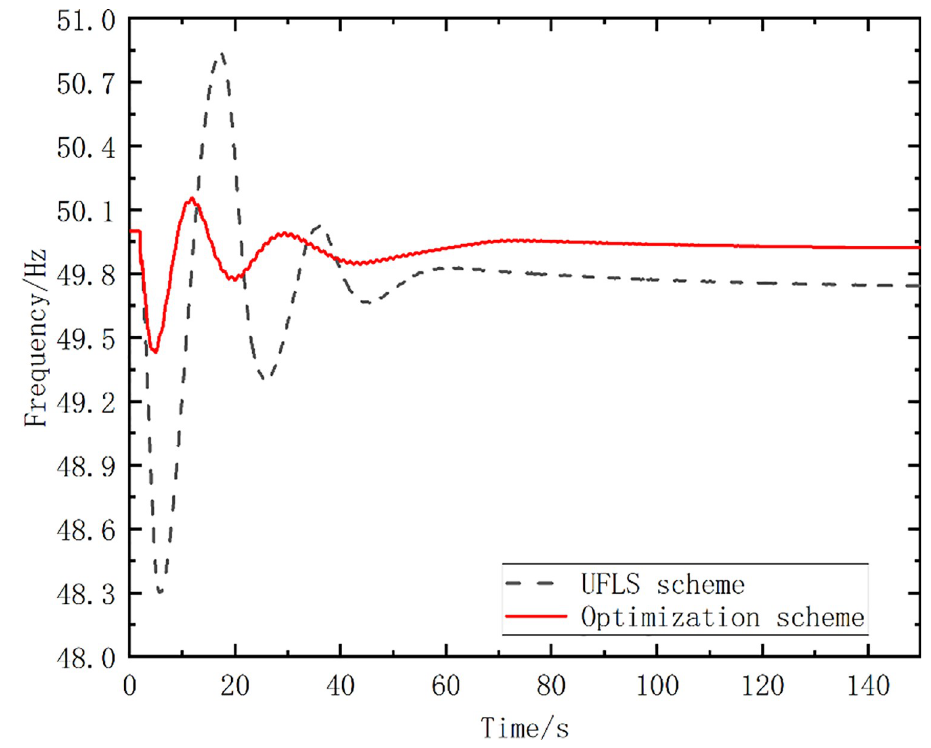
Fig 9. Simulated frequency curves.